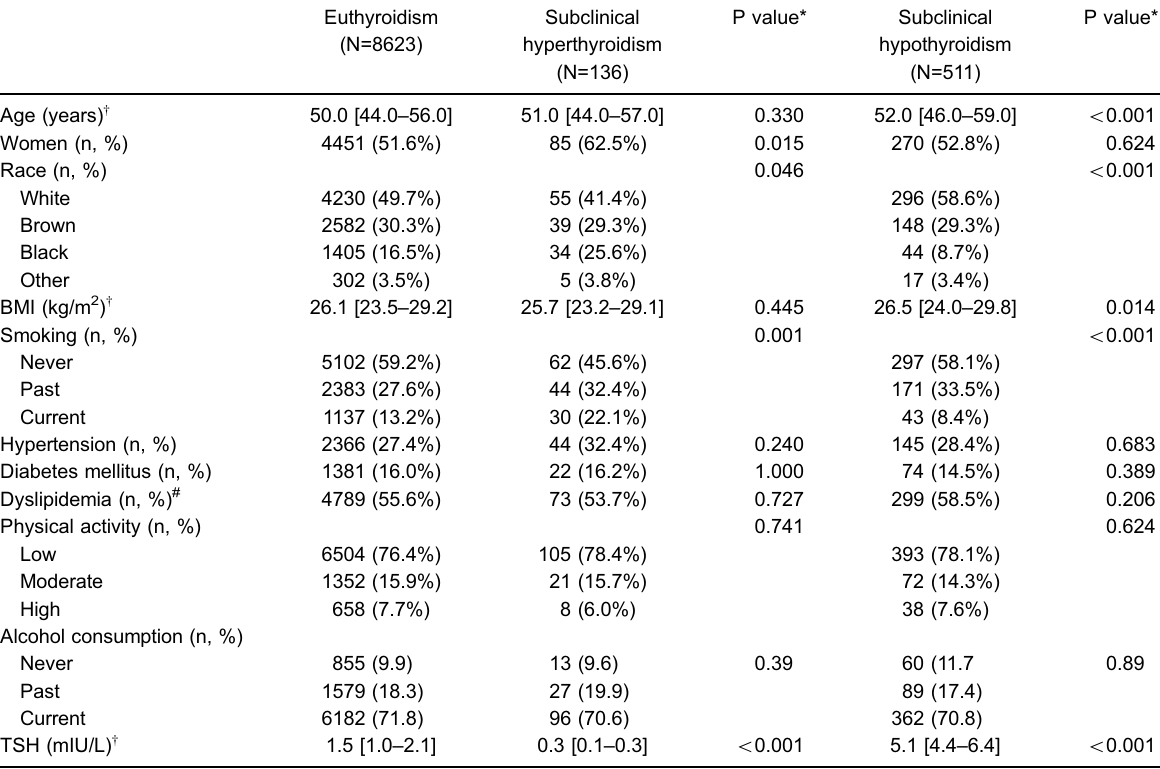
Table 1. General characteristics of the sample according to the presence of subclinical thyroid dysfunction.